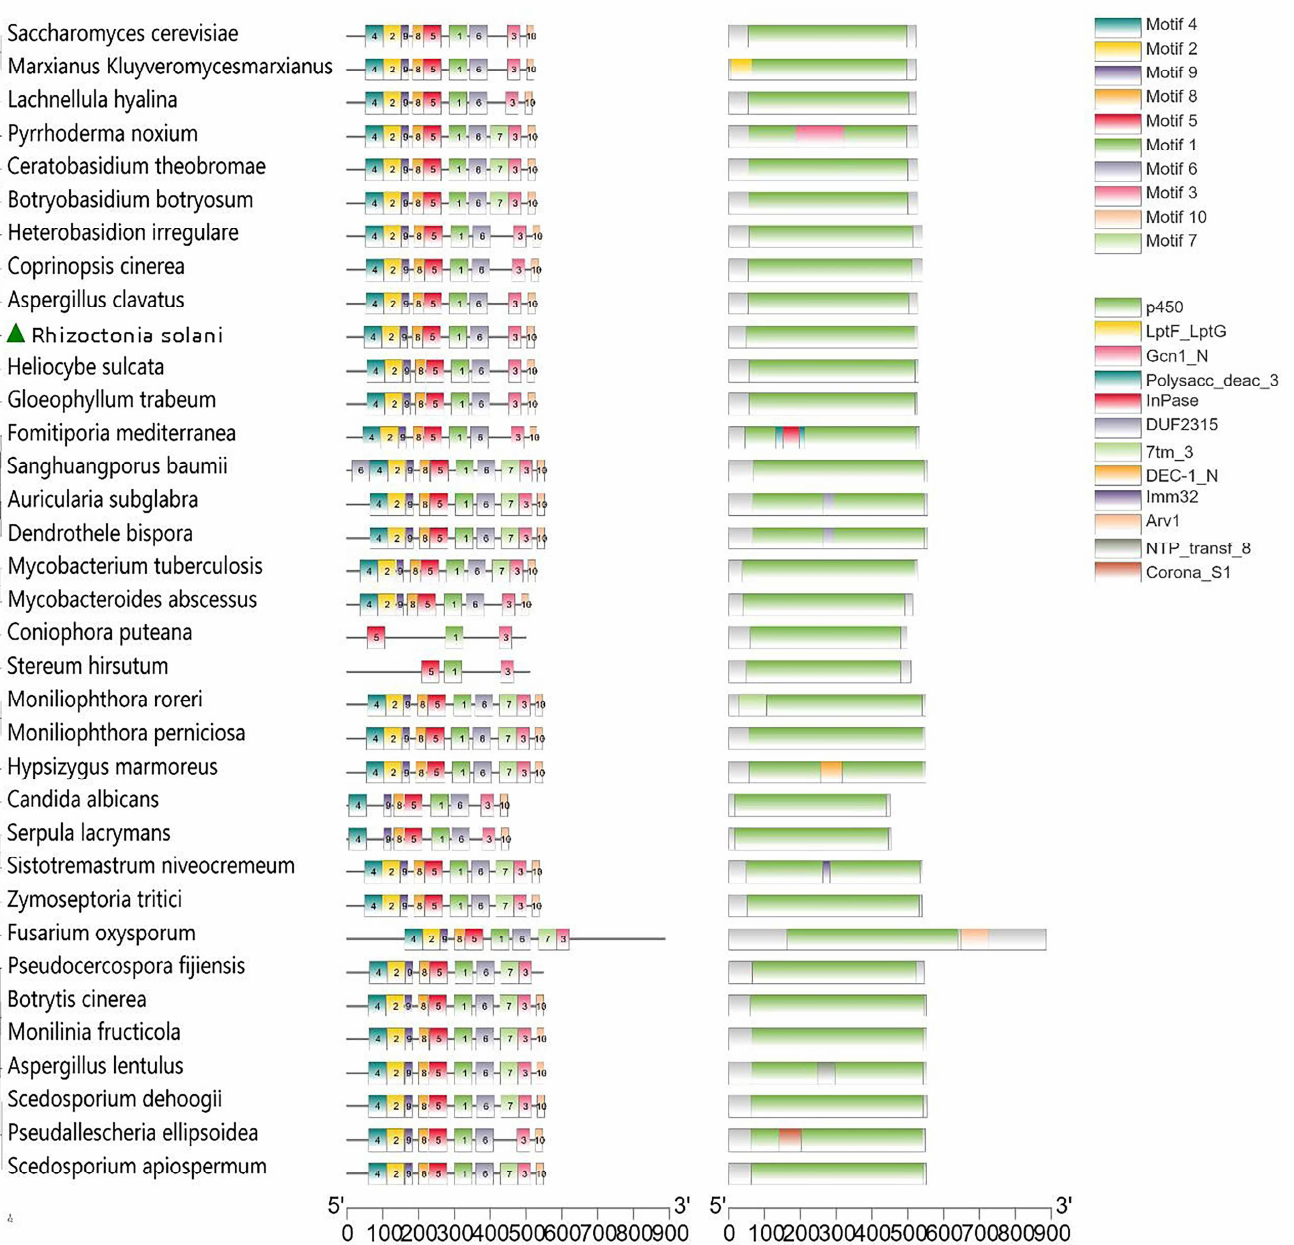
Figure 4. The evolutionary tree and gene structure of sterol 14α-demethylase from different spe- cies.